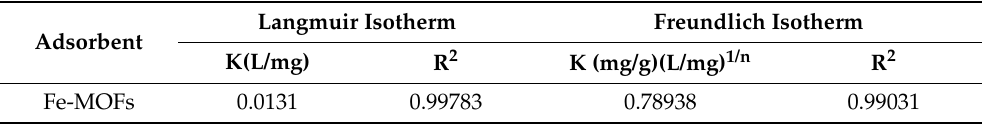
Table 3. Summary of Langmuir and Freundlich isotherm constants for the removal of RhB by